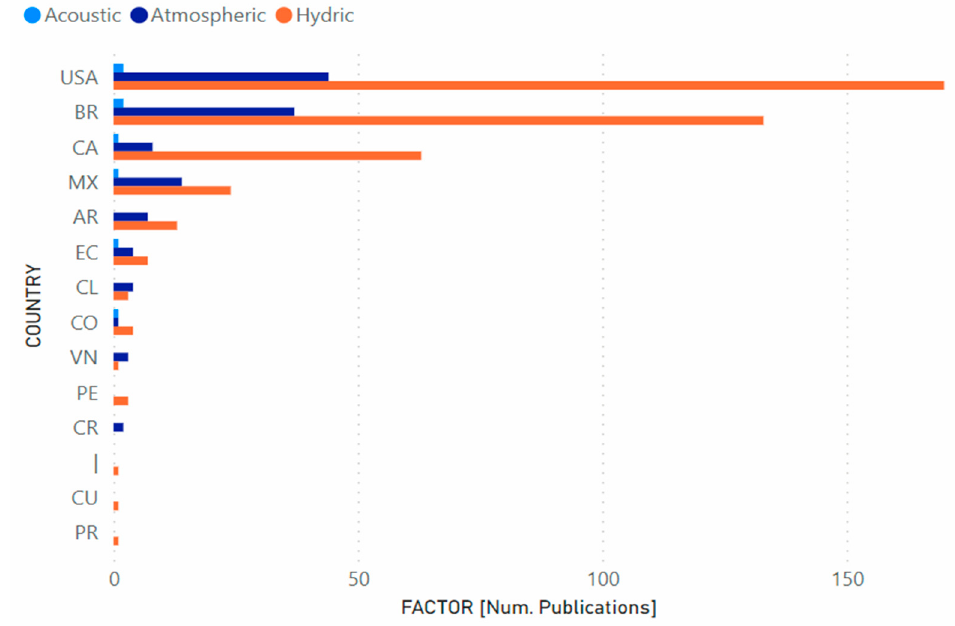
Figure 6. Contribution of scientific publications by country and factor.